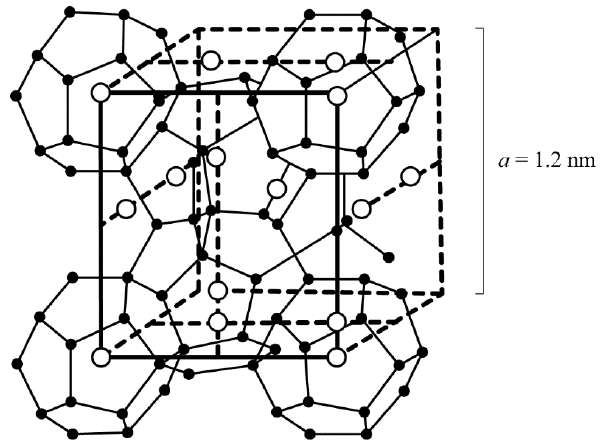
Figure 1. A unit cell of the cubic structure I (CS-I) gas hydrates (● -oxygen atoms, ○ -gas molecules included) [2].